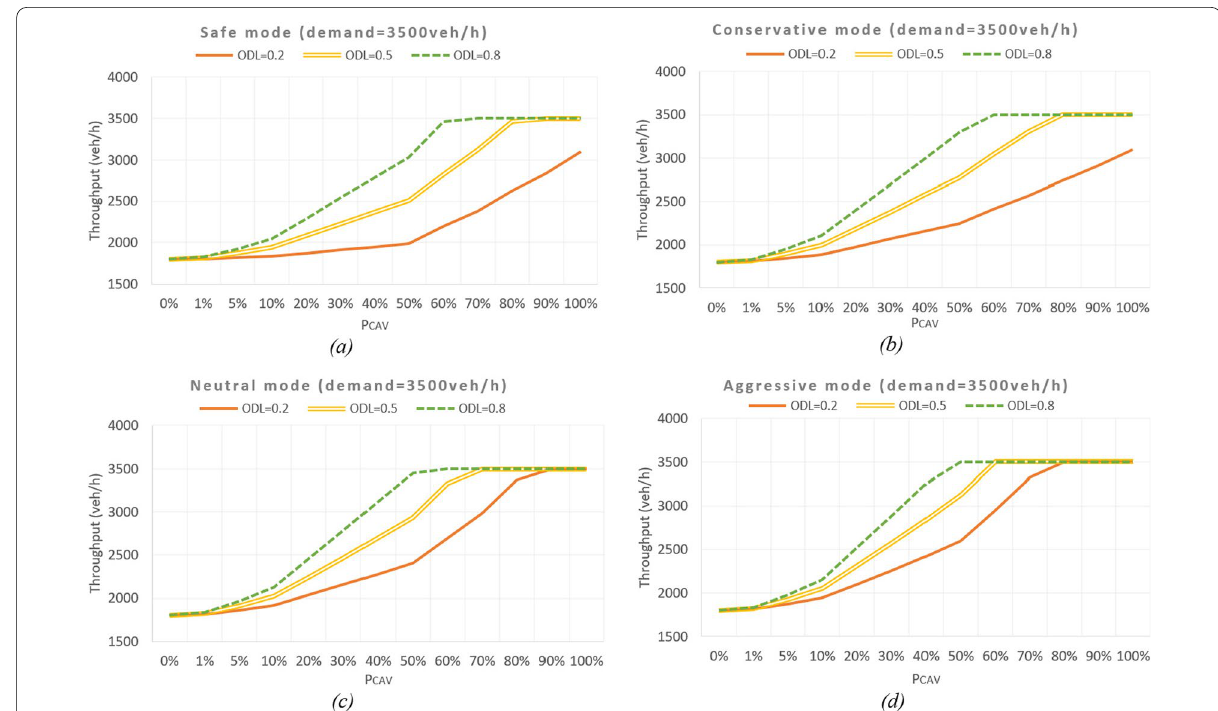
Fig. 6 Traffic throughput with different O DL on a two-lane freeway under 3500 veh/h traffic demand and different driving